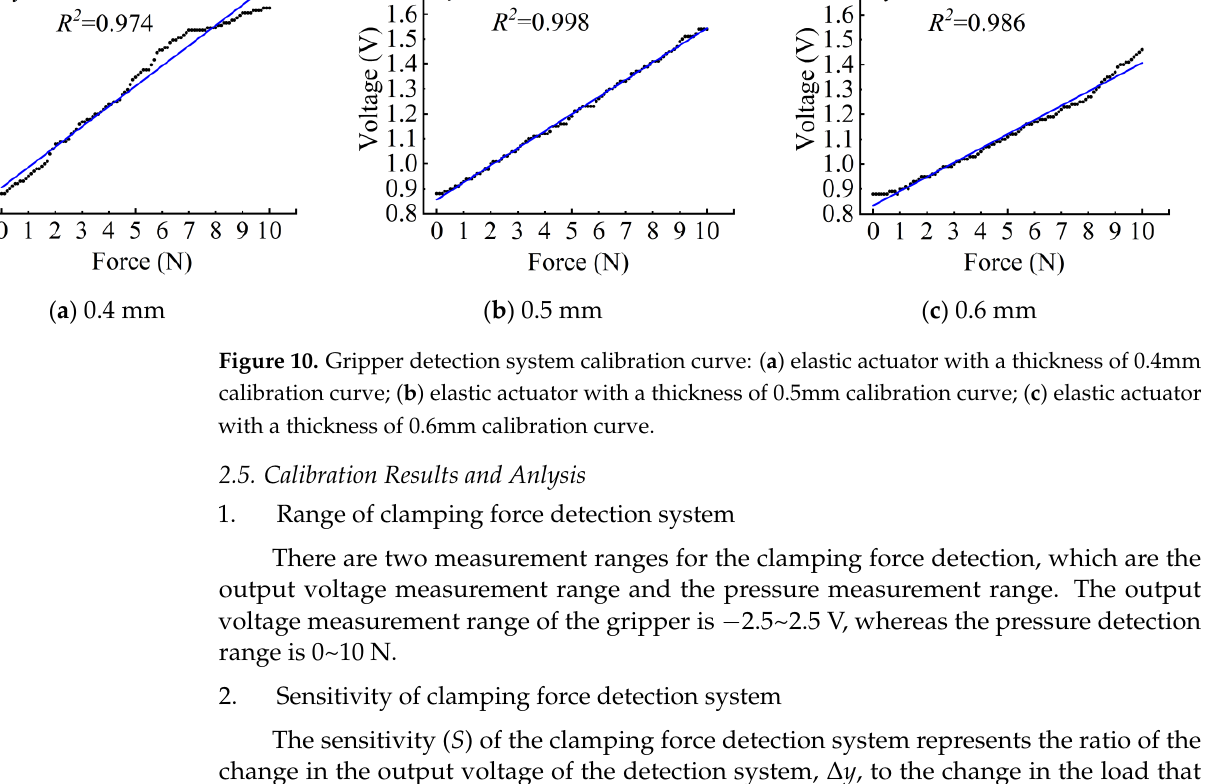
Figure 9. Clamping force detection system calibration testing field.